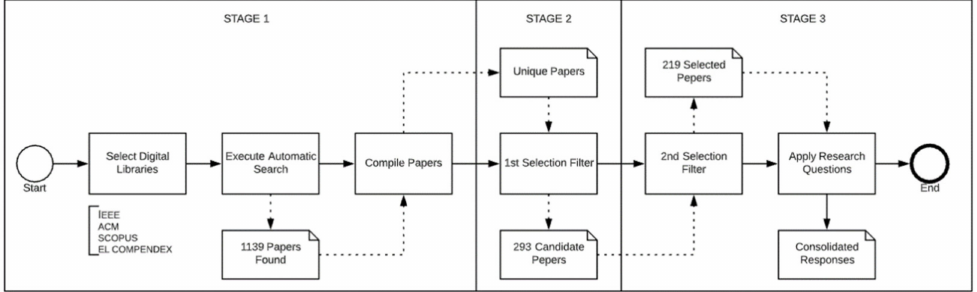
Figure 3. Publication’s selection process